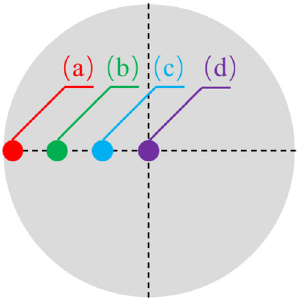
Figure 3. Schematic diagram of selection of ore phase field of view of pellet cross-section .